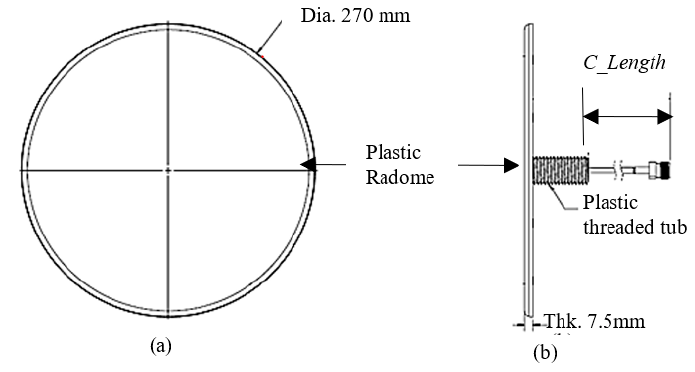
Figure 9. ( a ) Top view and ( b ) side view of the proposed ultralow-profile, ceiling mount antenna’s form factor with pigtail